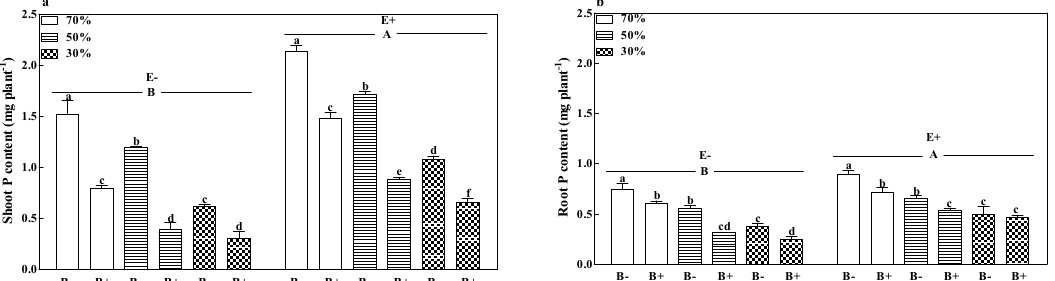
Figure 4. Shoot P content ( a ) and root P content ( b ) of perennial ryegrass infected with (E+) or without (E − ) fungal endophyte and inoculated (B+) or noninoculated (B − ) with pathogen at 70%, 50%, and 30% soil water regimes at harvest. Mean ± SEM of four replicates are shown. Bars topped by the same lowercase letter indicate no significant difference between soil water regimes and pathogen within fungal endophyte treatments at p ≤ 0.05 by Tukey’s HSD test. Bars topped by the same uppercase letter indicate no significant difference associated with fungal endophyte at p ≤ 0.05 by Tukey’s HSD test.